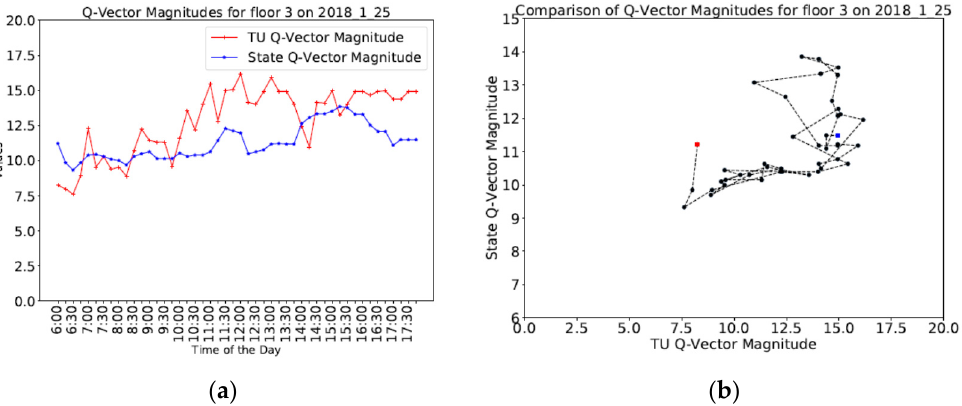
Figure 9. ( a ) Temporal variation of Q-vector magnitudes ( b ) Scatterplot of TU and state Q-vector magnitudes.